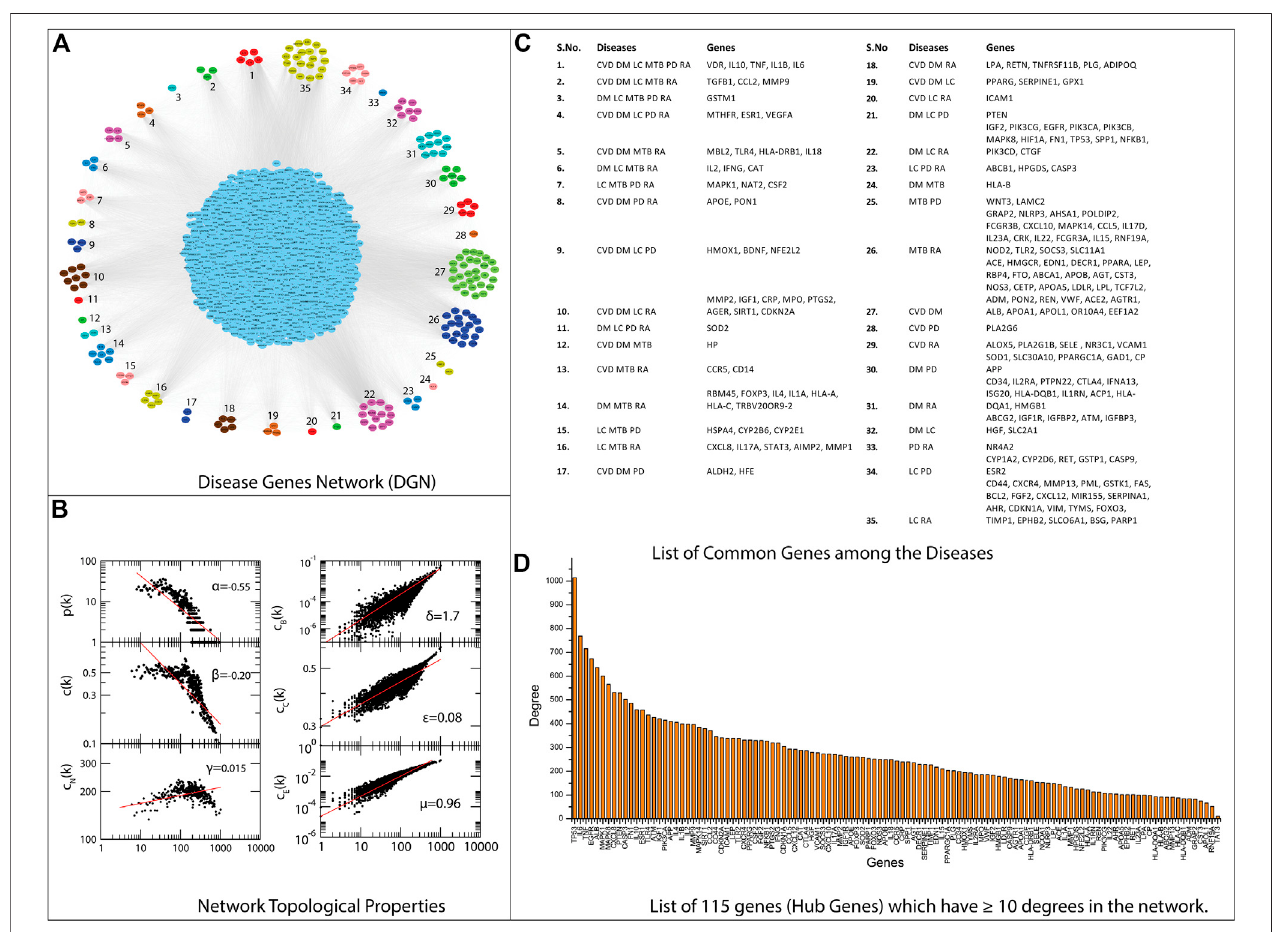
FIGURE 3 | (A) Disease Gene Network (DGN). (B) DGN topological properties. (C) List of common genes among the Diseases, e.g., tuberculosis (TB), diabetes mellitus (DM), rheumatoid arthritis (RA), cardiovascular diseases (CVD), Parkinson ’ s disease (PD), and lung cancer (LC). (D) List of 115 genes that have ≥ 10 ° degrees in the